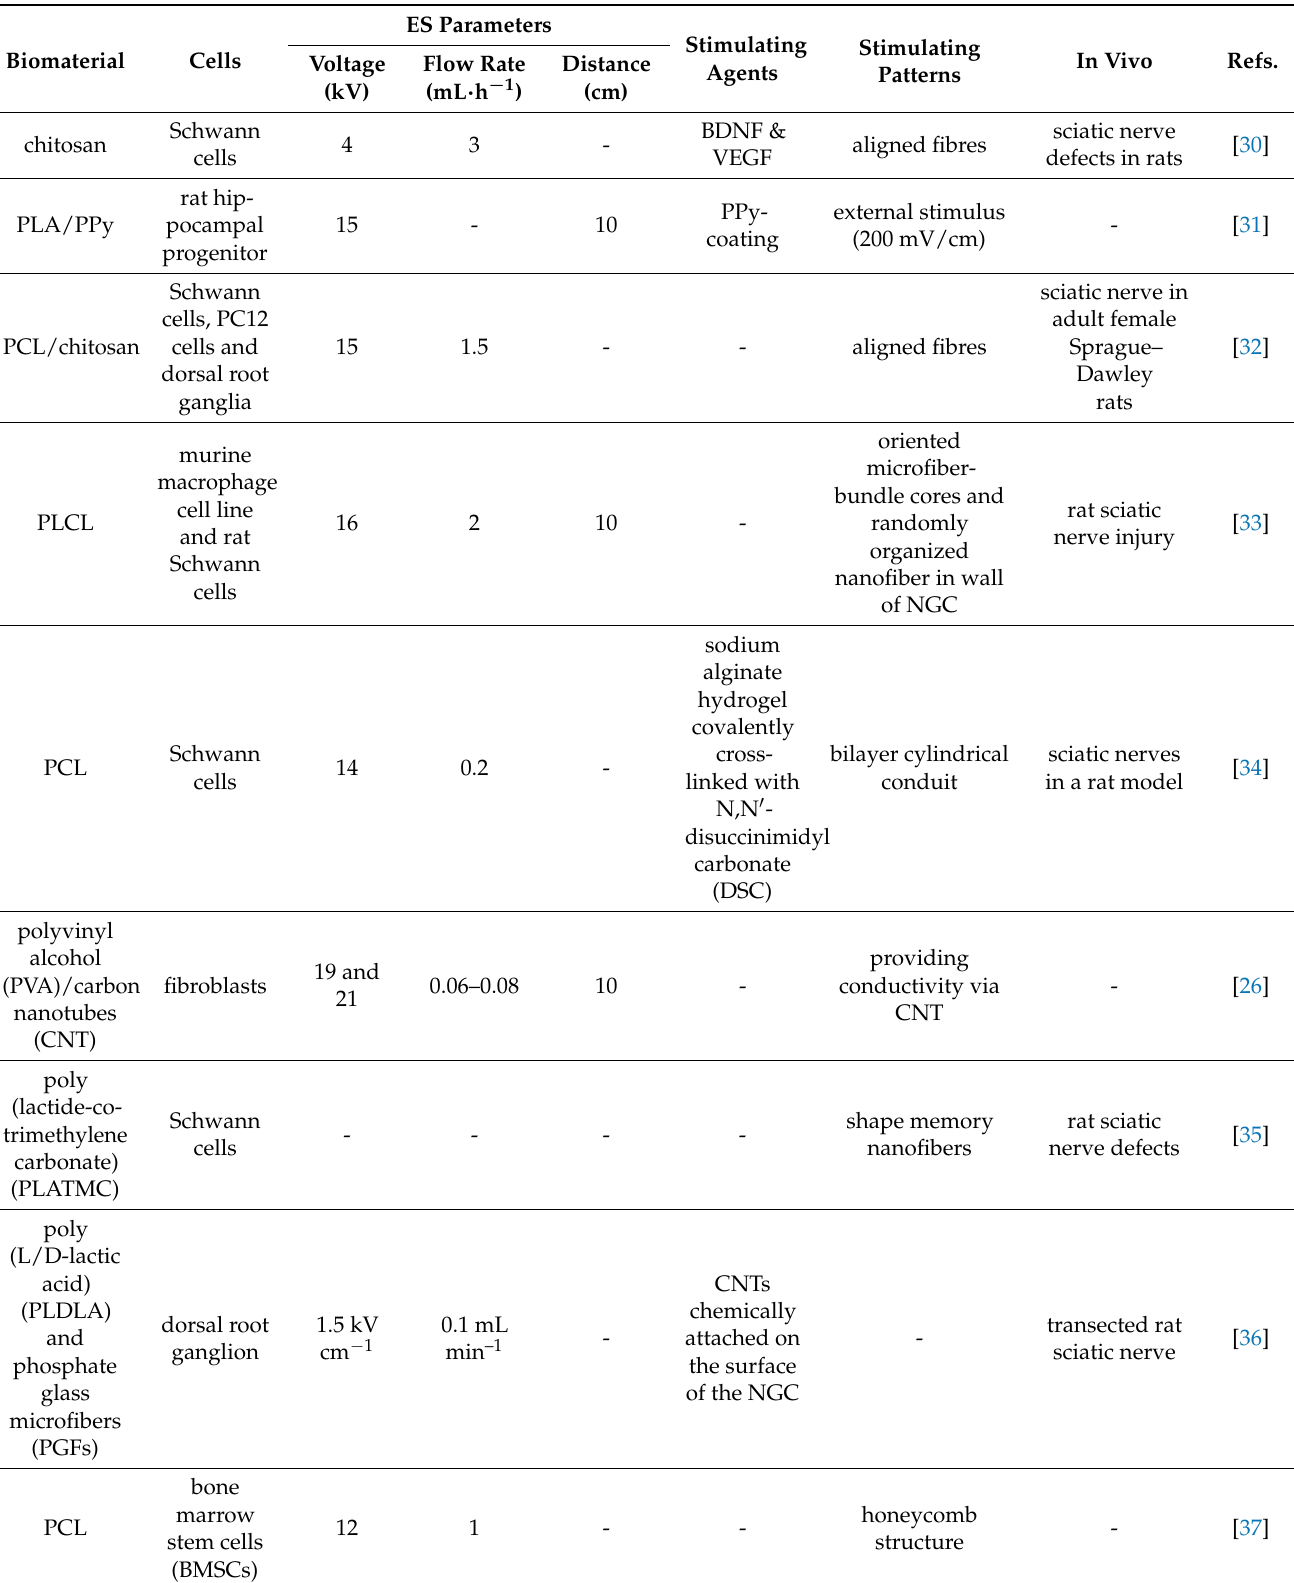
Table 1. Recent studies focusing on the use of electrospun nerve conduits for regenerating periph- eral